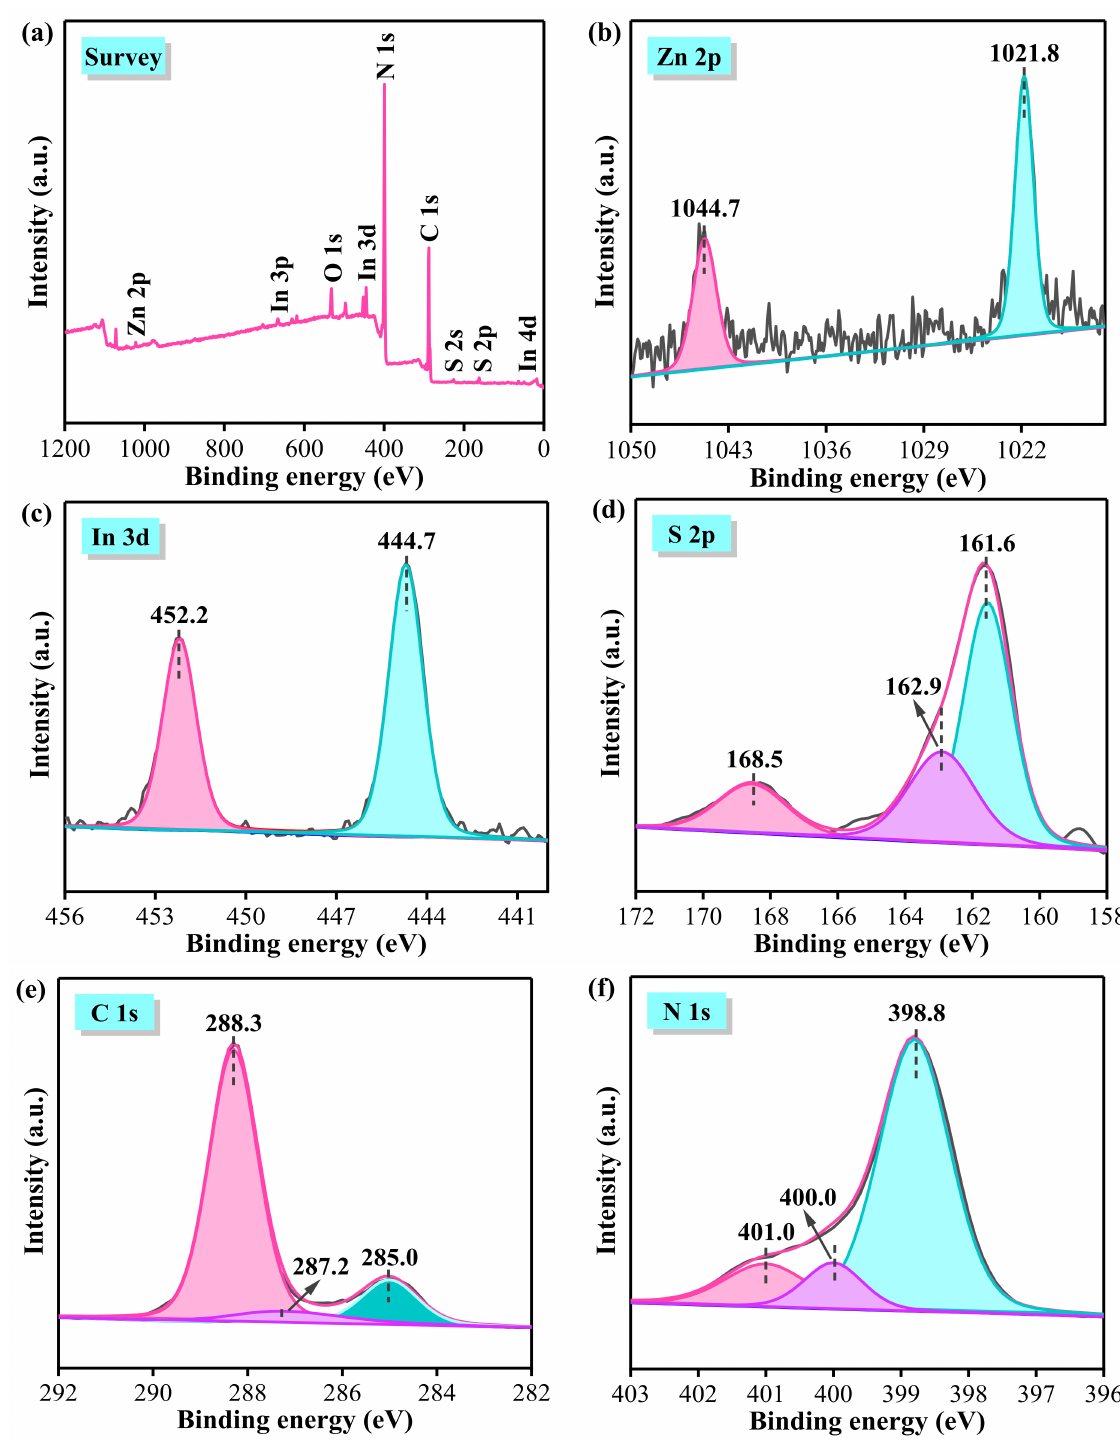
Figure 5. XPS spectrum of 20%ZIS/CN: ( a ) survey XPS spectra; ( b ) Zn 2p; ( c ) In 3d; ( d ) S 2p; ( e ) C 1s; ( f ) N